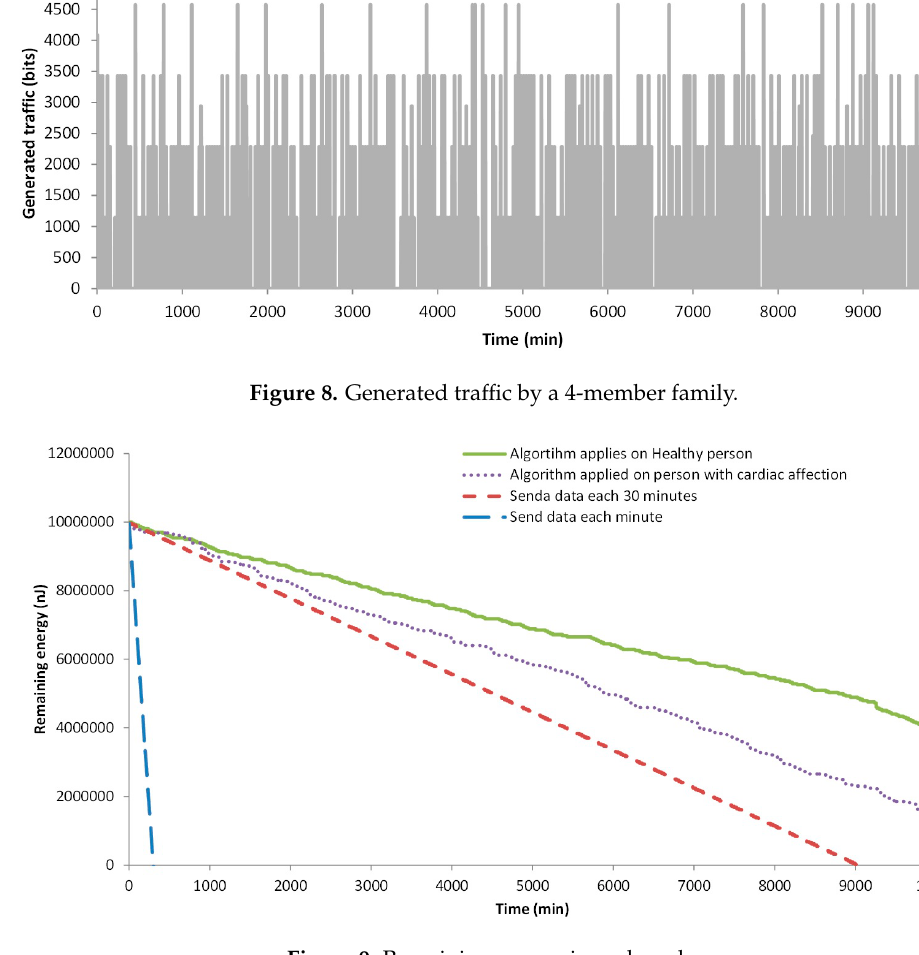
Figure 9. Remaining energy in each node.